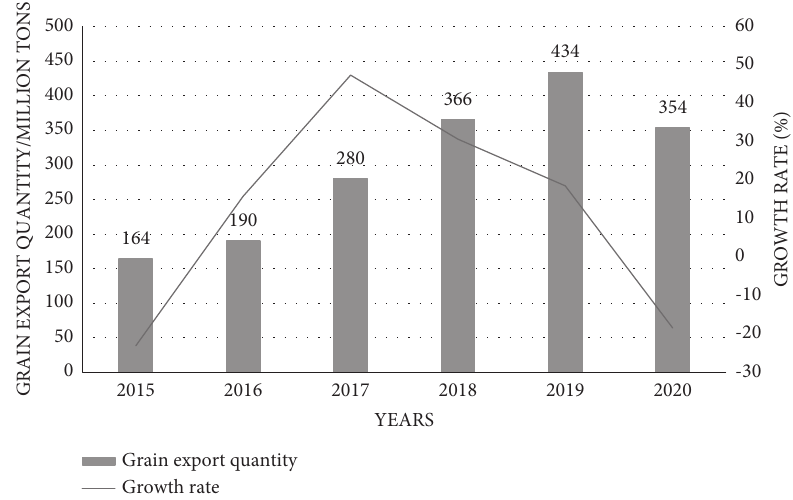
Figure 1: China’s grain export quantity and growth rate chart from 2015 to